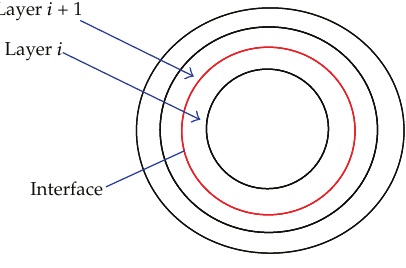
Figure 5: Concentric layer model. Table 2: Axis-symmetrical analysis results—comparison, Vaz et al. (cid:4) 11 (cid:5) , Sævik and Bruaseth (cid:4) 12 (cid:5) , and Skeie (cid:4) 5 (cid:5)